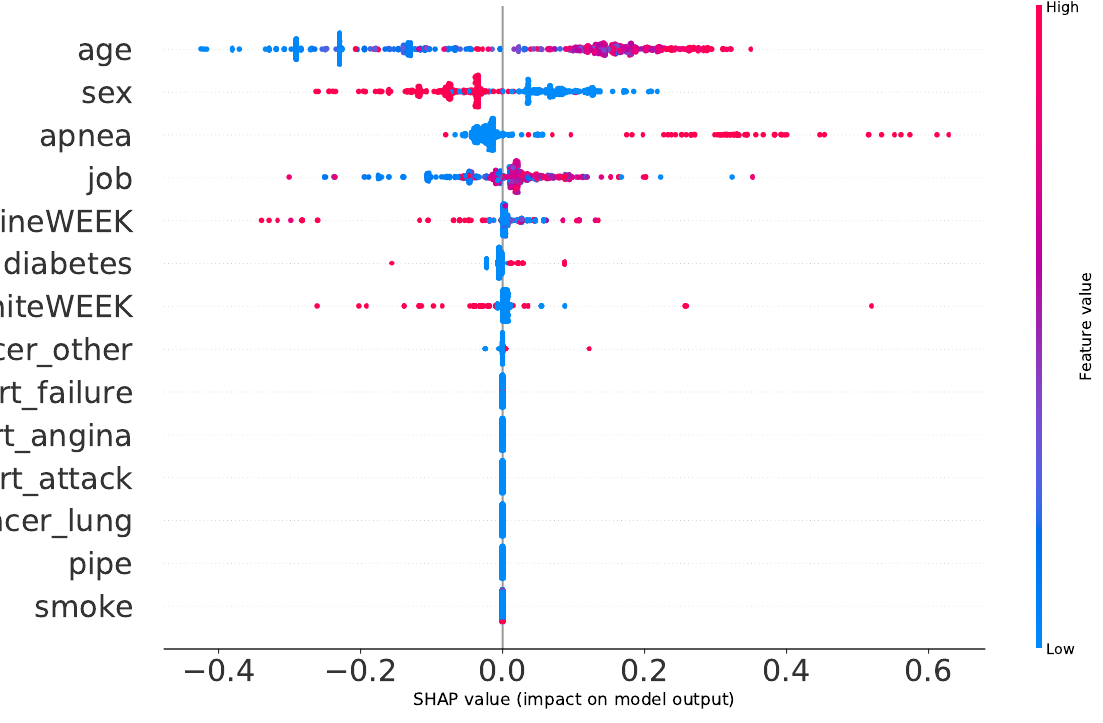
Figure 5. Impact of variables with SHAP, Decision Tree with Stud selection, with pathologies. GA with tournament selection for Decision Tree (DT-T): Thanks to the feature se- lection, with only 16 variables, an accuracy reaching 0.7492 was achieved in the best cases and an average of 0.7103, as shown in Table